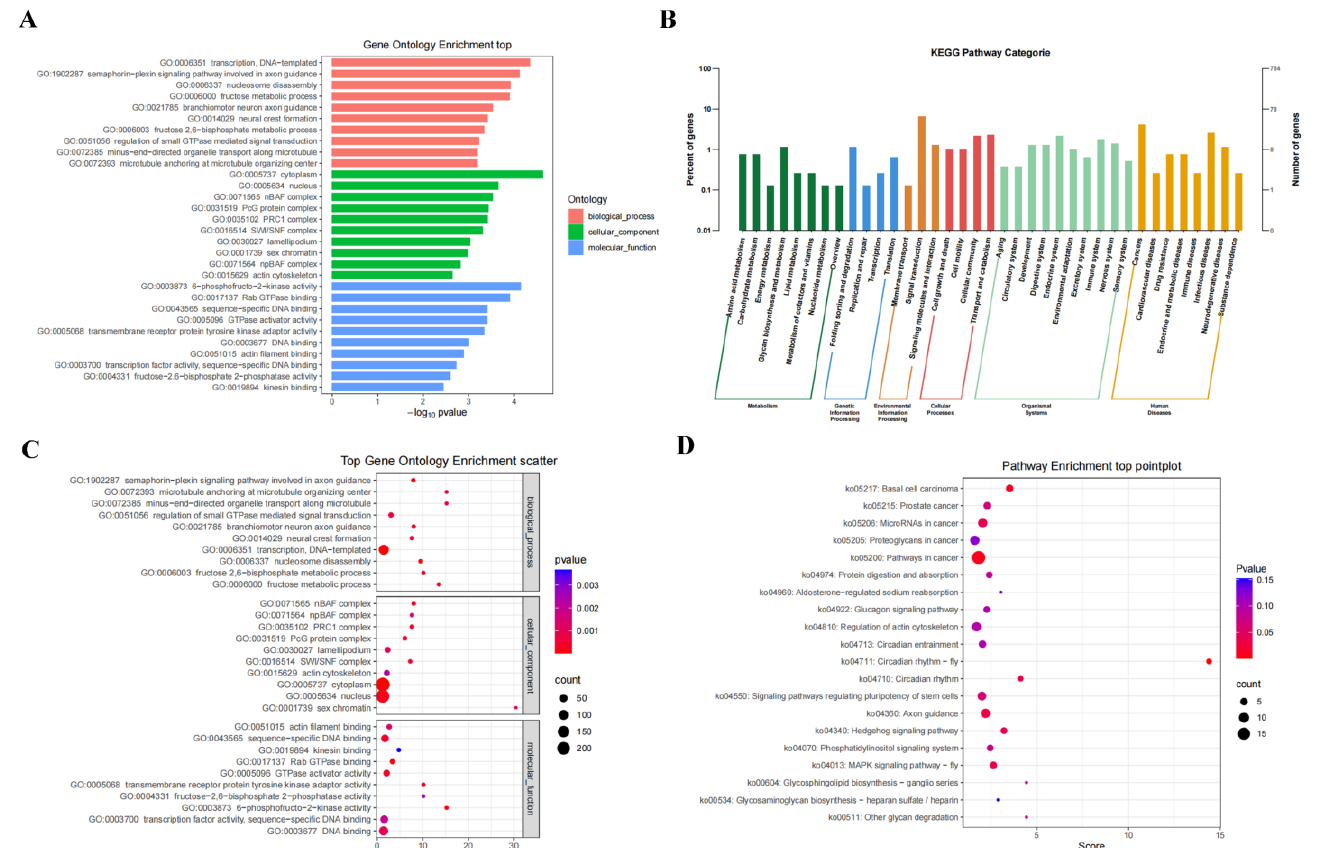
Figure 2. GO and KEGG pathway enrichment analysis of the target genes of DEmiRNAs from the spleen in C. altivelis following NVV challenge. The DEmiRNAs caused by NNV infection were matched to various GO and KEGG pathway categories. ( A ) Bar chart of top10 statistics of GO enrichment of DEmiRNAs target genes in biological process, cellular component, and molecular function, respectively. ( B ) Bar chart of KEGG enrichment of DEmiRNAs target genes. ( C ) Significant GO enrichment function scatters plot of DEmiRNAs target genes. ( D ) Scatter plot of KEGG pathway enrichment top20 statistics after NNV infection.